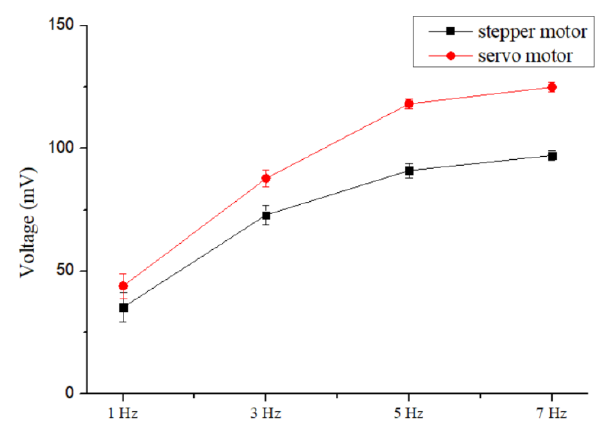
Figure 20. The electrical energy output results at different frequencies: ( a ) stepper motor electrospinning; ( b ) servo motor electrospinning.